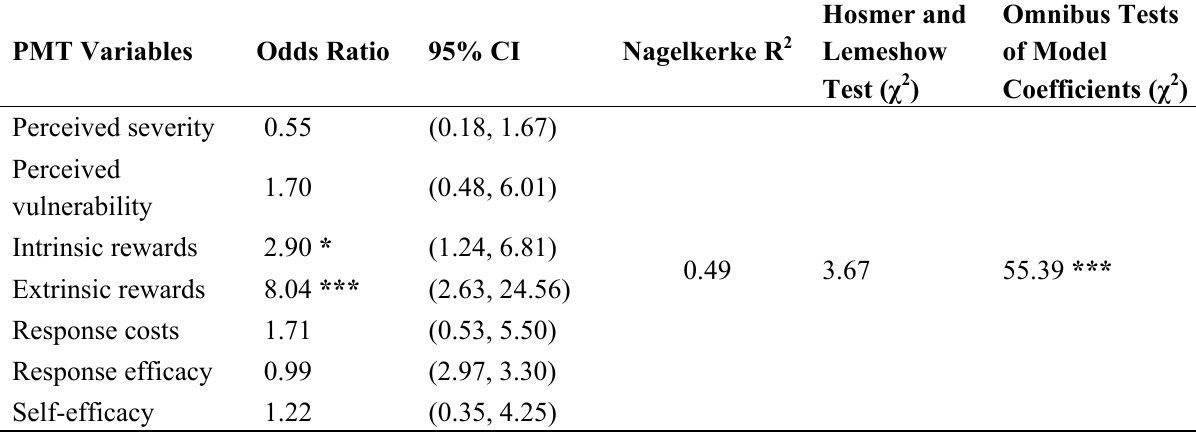
Table 3. PMT Predictors of Drug Use Intention (N =